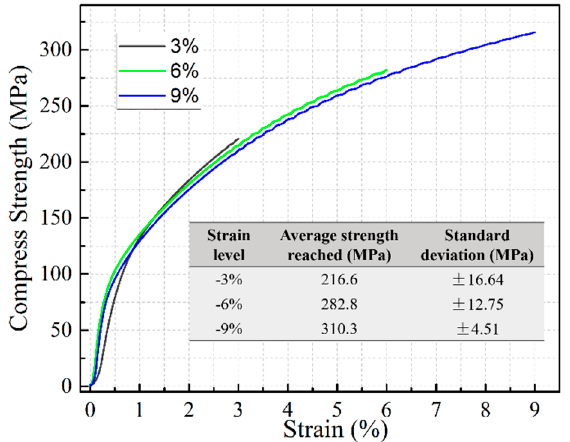
Figure 1. Schematic presentation: ( a ) dimensions for creep samples; ( b ) inverse pole figure in compression direction and KAM map, for solid-solution-treated sample; ( c ) heat treatment process flow.